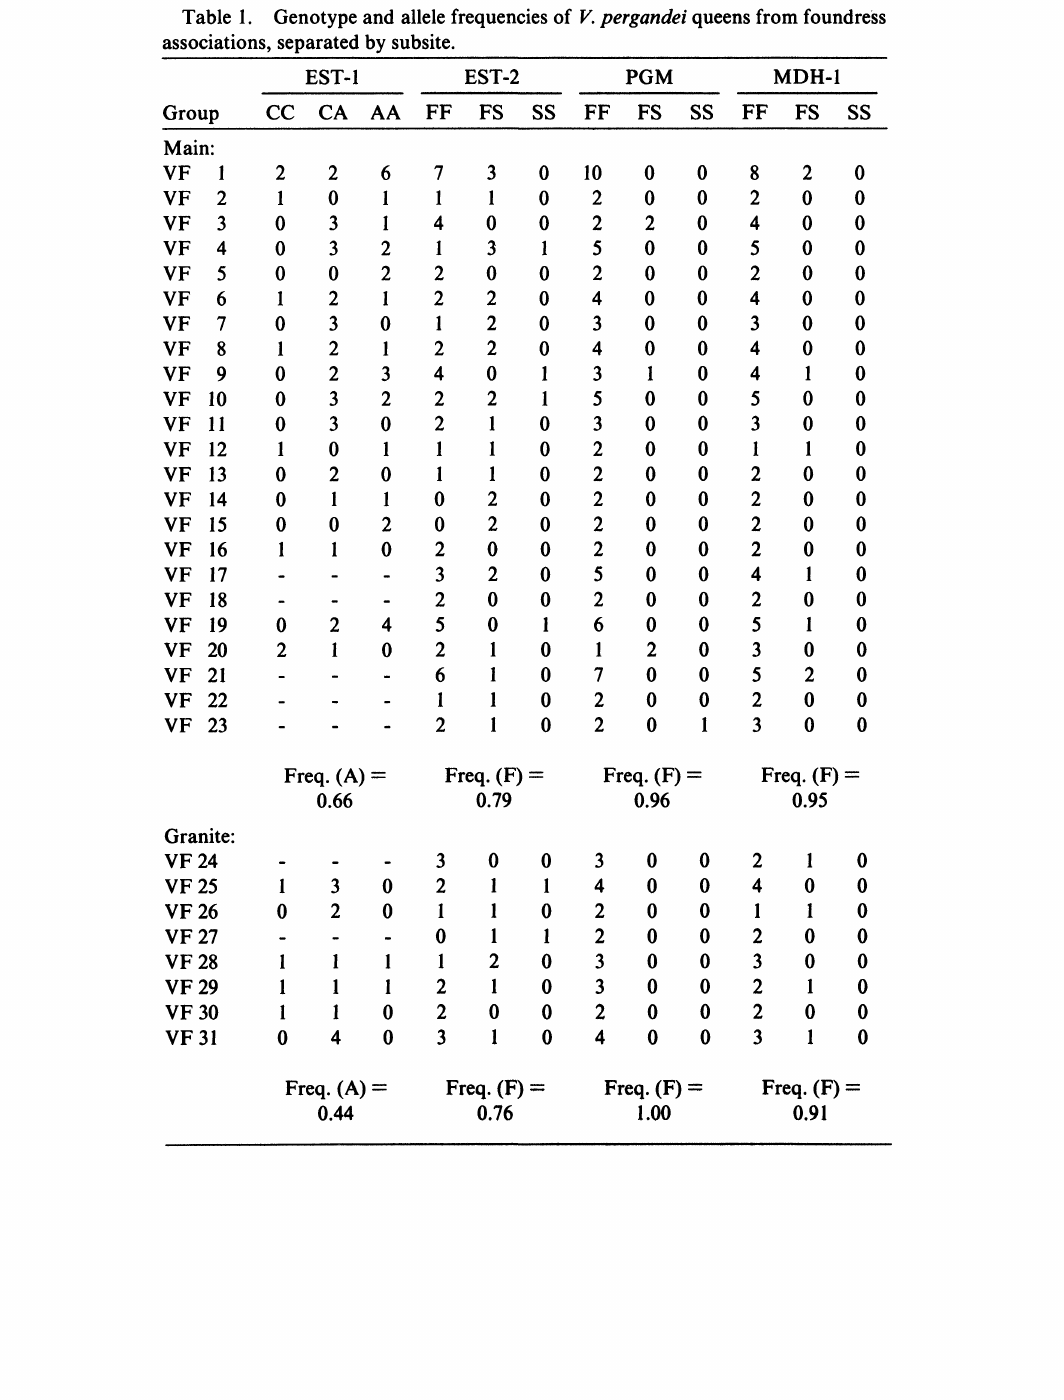
Table 1. Genotype and allele frequencies of z. pergandei queens from foundress associations, separated by